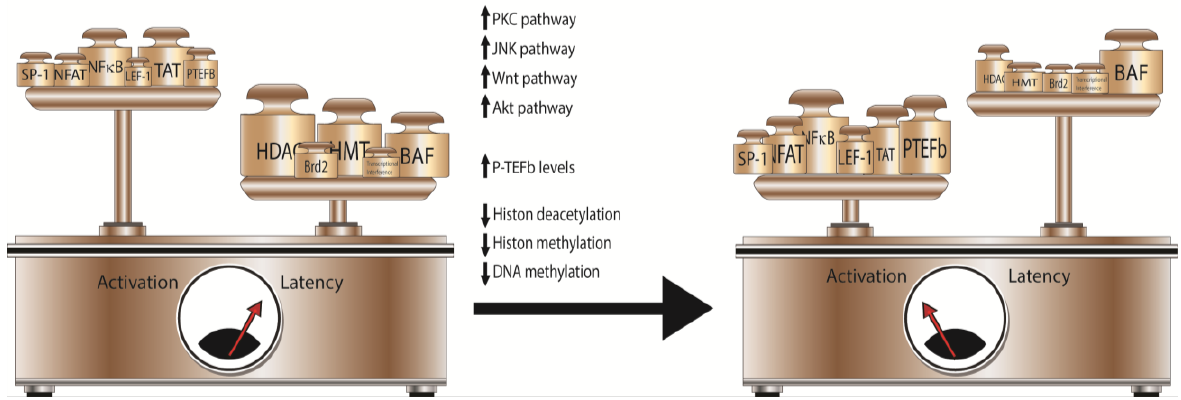
Figure 1. Multiple pathways can be targeted for reverting HIV latency. Silencing of viral transcription results from the concerted activities of LTR-repressive and activating factors and co-factors. The use of combinatorial therapy, targeting multiple pathways involved in the modulation of HIV transcription, will increase the likelihood of reversing the balance from latency to